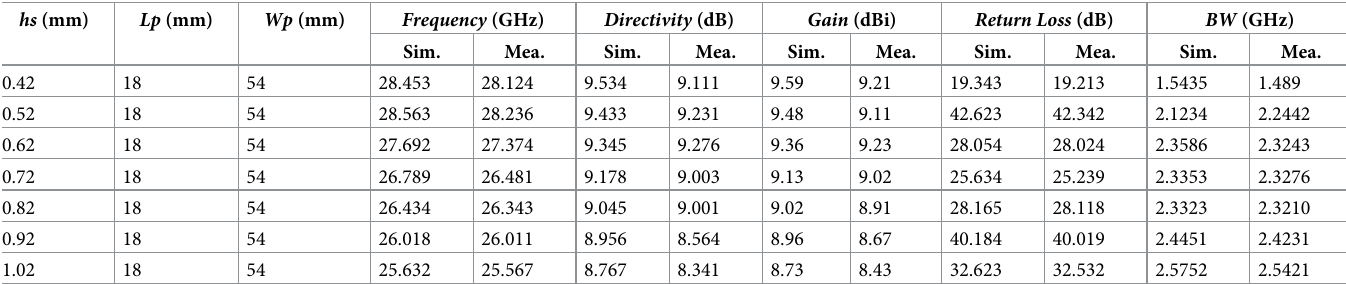
Table 3. Simulated and measured variation of antenna design parameters with substrate thickness at 28GHz. hs